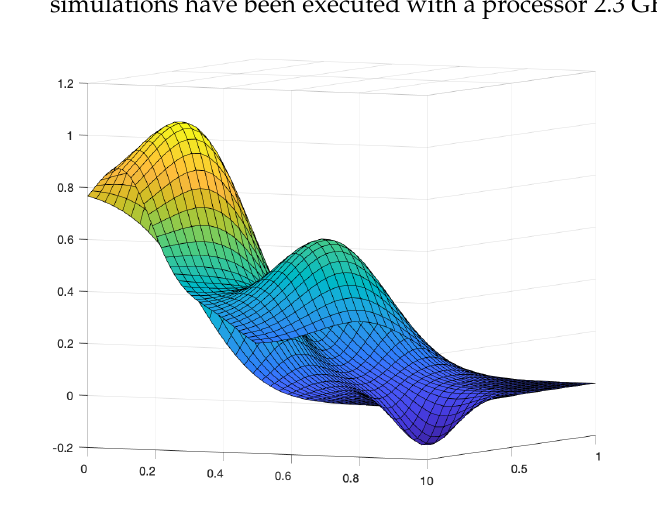
Figure 1. Test function in Equation (13). Table 1. RMSEs for SPH (standard formulation) and with p = 1. Data sites Ξ G and Ξ H .